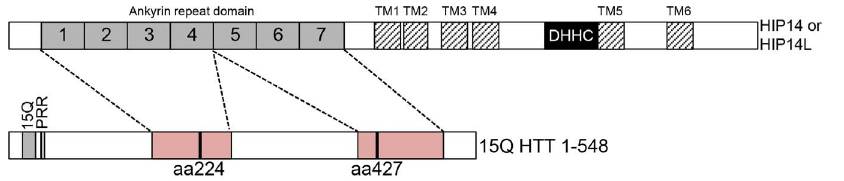
Figure 5. A schematic diagram of the two hypothetical binding scenarios of HTT with HIP14 or HIP14L. In both ( A ) and ( B ) for HIP14 or HIP14L the numbered, solid grey boxes are the seven ankyrin repeats that make up the ankyrin repeat domain, the six TMDs are in hatched boxes labeled TM1–TM6, and the DHHC-CR domain is a black box labeled DHHC. ( A ) In this first scenario, the HIP14 and HIP14L HTT binding site (solid pink box) is between amino acids 224–427 and this binding site interacts with the ankyrin repeat domain of HIP14 or HIP14L. ( B ) In an alternate scenario there are two binding sites (solid pink boxes), one between amino acids 1–427 and the other between amino acids 224–548, that both interact with the ankyrin repeat